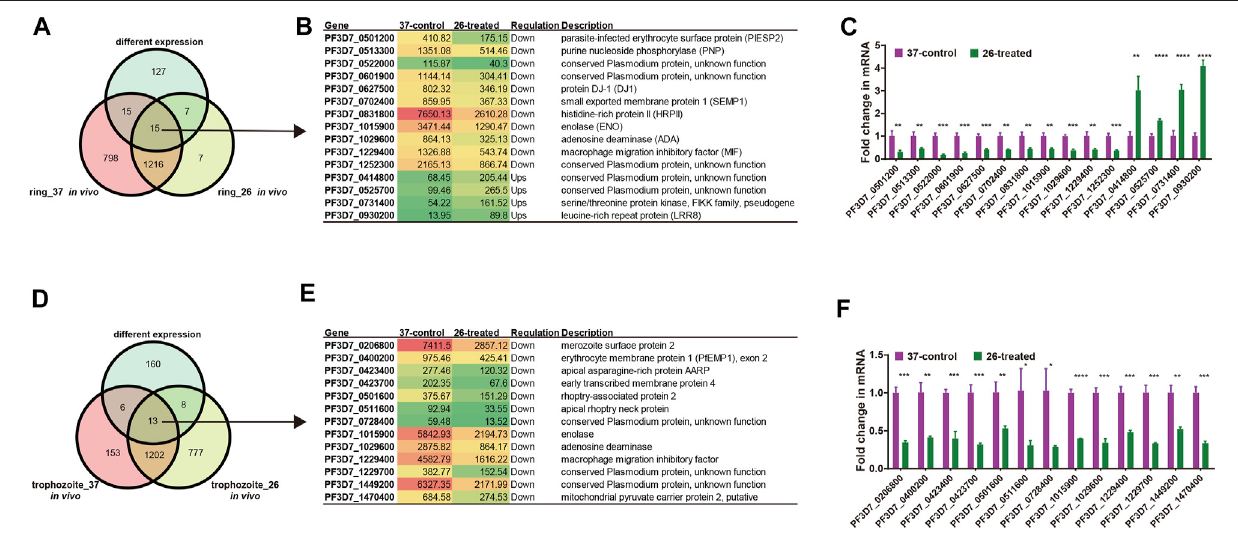
FIGURE 8 | List of genes included in our structure analysis. (A, D) Overlap of Plasmodium mRNAs in the ring stage (A) and trophozoite stage (D) with adequate structure probing in vivo coverage between 26 ° C and 37 ° C temperature and with different expressions between two temperatures. (B, E) List of all genes with different expressionsaftercoldresponseintheringstage (B) /trophozoitestage (E) andwithaveragenucleotidecoverageabove2.Columnsshow,foreachgene,thegenename, the FPKM value, the regulation, and gene description. Red color indicates high expression level and green color indicates low expression level. (C, F) qPCR analyses of transcriptional regulation [fold changes at 3 h and 26 ° C temperature stimulation to 37 ° C at 45 h (ring stage)/70 h (trophozoite stage)] after invasion. A comparison ofthe gene expression in different treated groups in thering developmental stage between RNA-seq and qPCR. Fold changesin the expression of different genesinthe 26 ° Ctreatmentgroup weredetectedbyqRT-PCR.The name ofeach geneisshown at the bottom. TheqPCR results were highly consistent with theRNA- seq analysis. The data are representative of three independent experiments. Two-sided t -test, * p < 0.05; ** p < 0.01; *** p < 0.001; **** p < 0.0001; ns, no signi fi cant ( t test; SDs from three